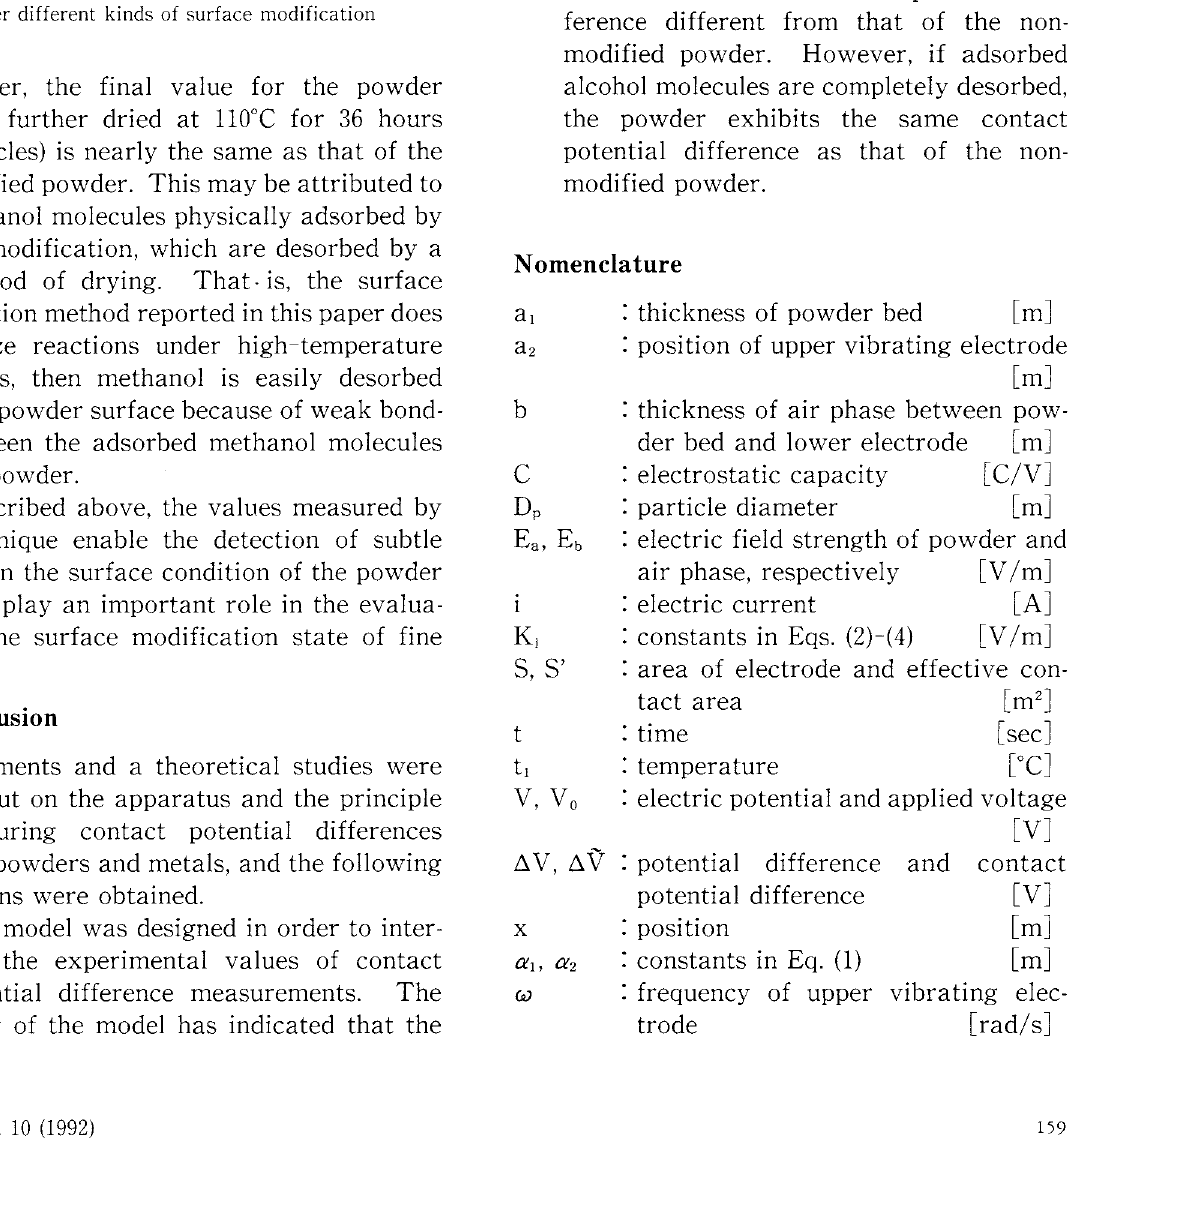
Fig. 8 Change of contact potential difference with time under different kinds of surface